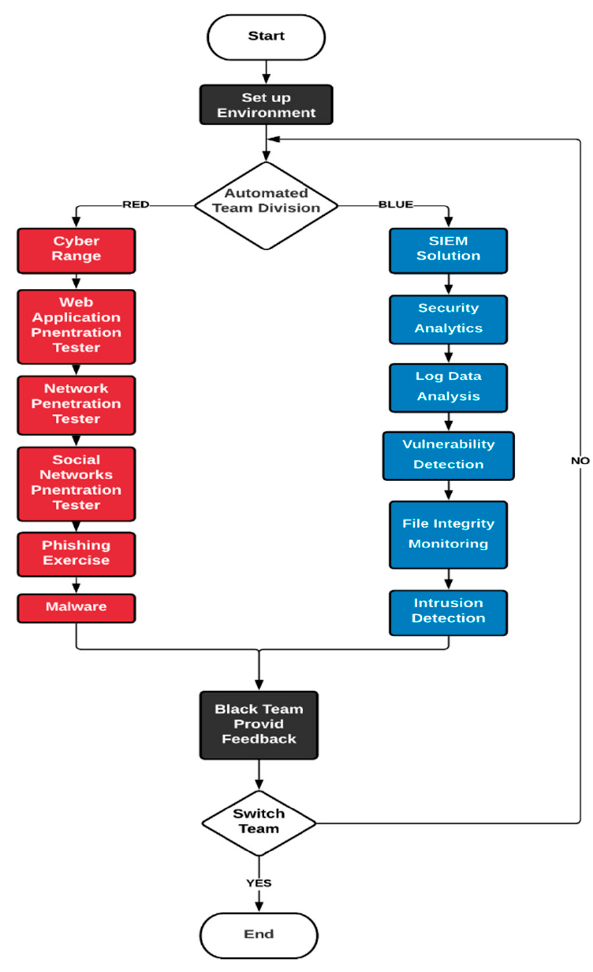
Figure 1. The division of teams into red and blue.